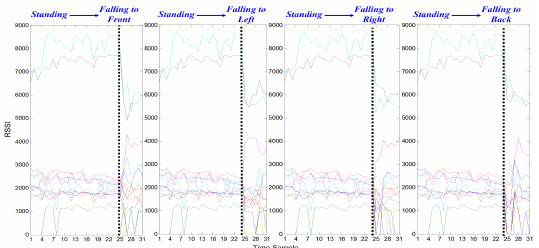
Figure 5: RSSIs variation patterns when a subject falls to different directions from